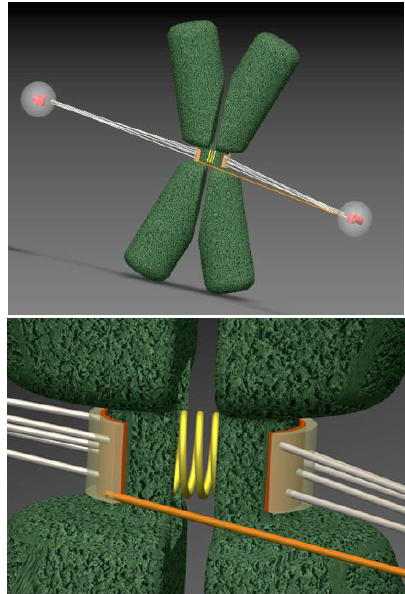
Figure 2. Merotelic KMT configuration for a congressed chromosome. Top image is a three-dimensional representation of a mammalian chromosome (green) positioned midway between two spindle poles. Sister chromatids (green) are connected by a stretchable centromere, represented as a spring (yellow). Bottom image is an enlargement of sister kinetochores, depicted as semi-transparent layers. Most of the attached MTs are in the proper amphitelic configuration (grey), extending from opposite spindle poles. However, although the chromosome has congressed and its sister kinetochores are positioned back-to-back, they can still bind improper merotelic MTs (one such MT is shown in orange). Computer-generated images are snapshots from video material in [23].